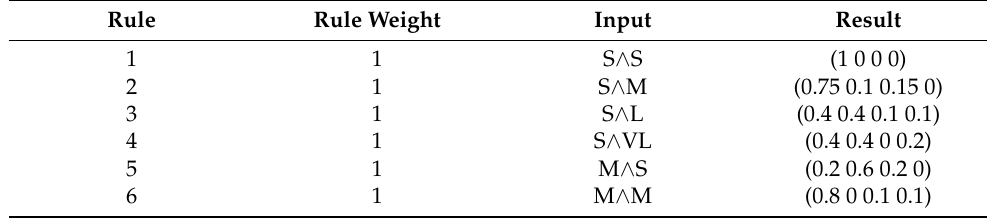
Table 7. Initial parameters of